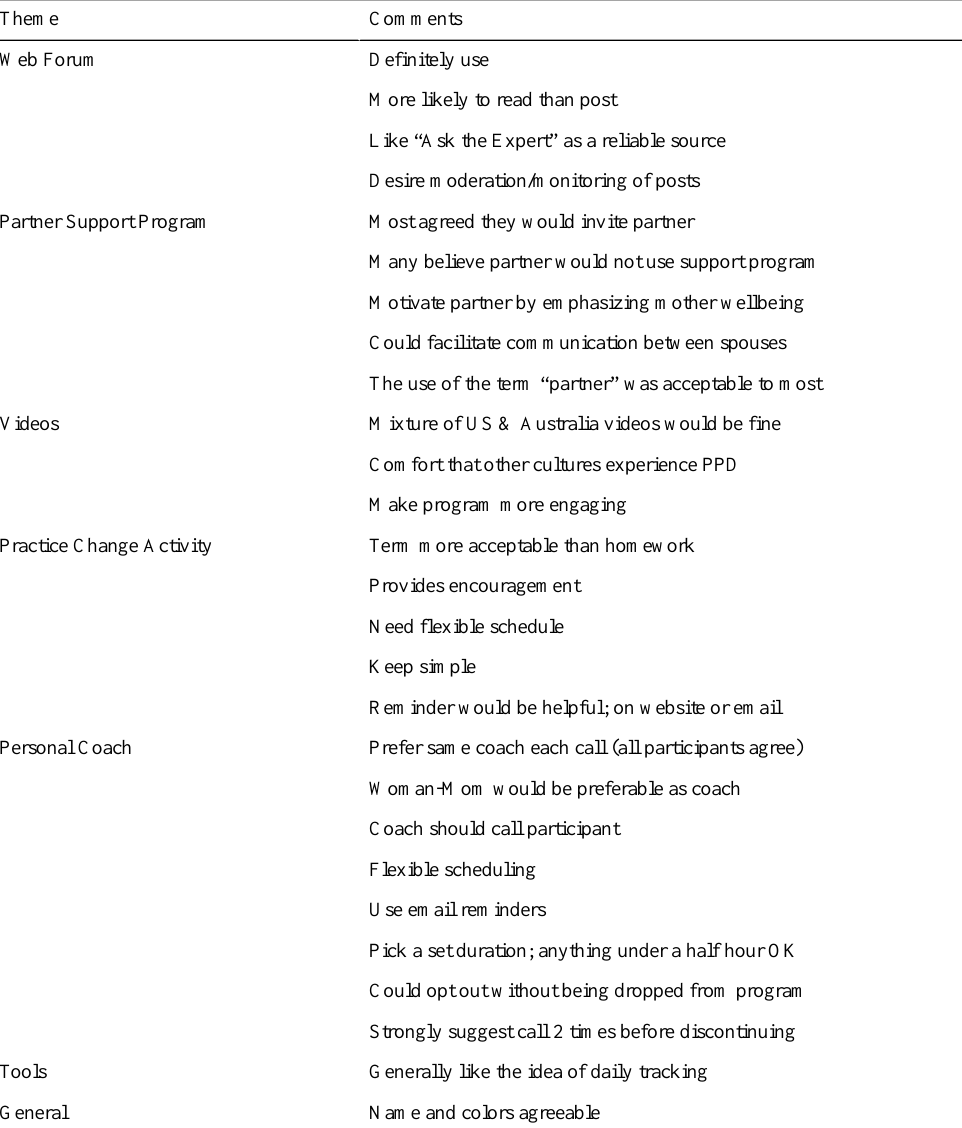
Table 2. Summary of comments from focus group